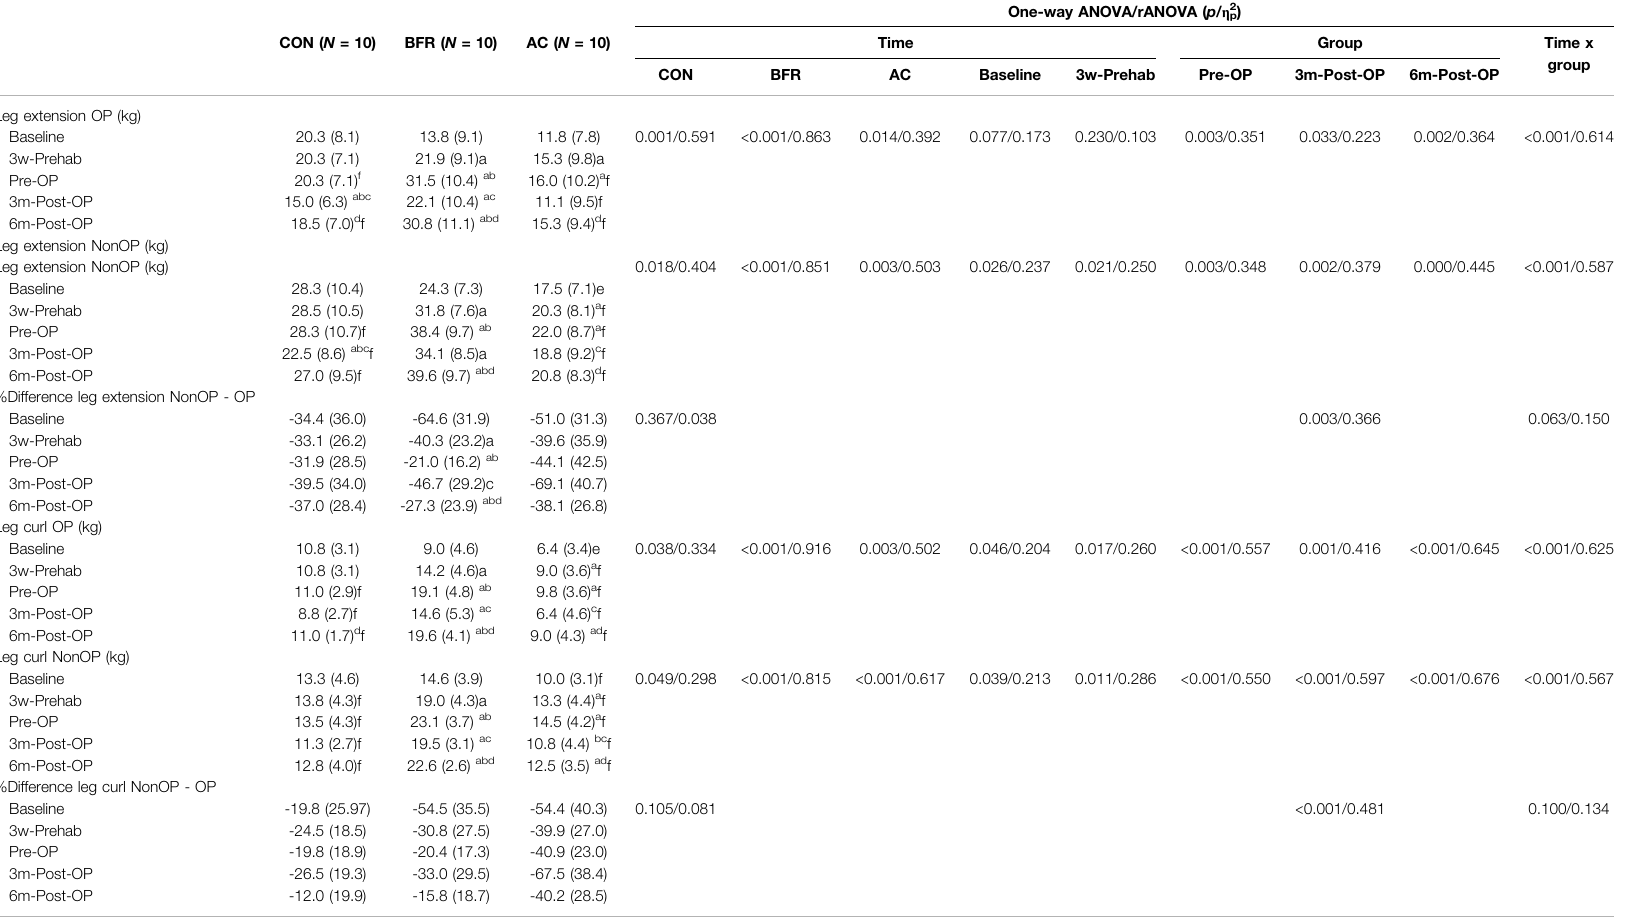
TABLE 6 | Measures related to muscular strength of lower extremities during the prehabilitation- and post-operative period.